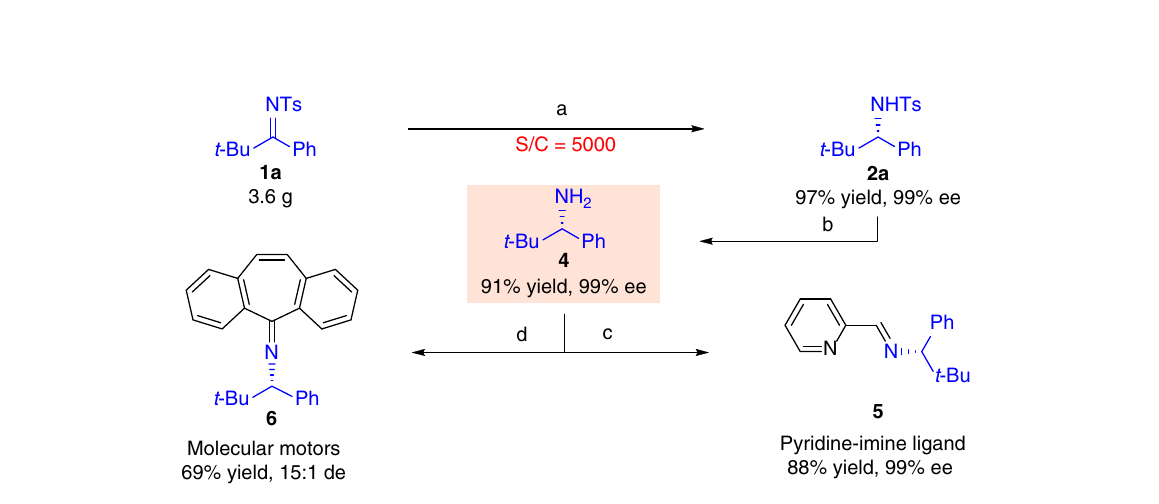
Fig. 2 Product derivatization. Reagents and conditions are as follows. a 1a (3.60 g), S / C = 5000, 60 atm H 2 , 60 °C, 48 h. b 2a (158 mg, 0.5 mmol), naphthalene (5.0 mmol), sodium (5.0 mmol), 1,2-dimethoxyethane (10 mL), – 70 °C-RT, 2 h. c 2-pyridinecarboxaldehyde, Et 2 O, RT, 16 h. d 5 H -dibenzo[ a,d ] [7]annulen-5-one, TiCl 4 , toluene, RT, 24 h